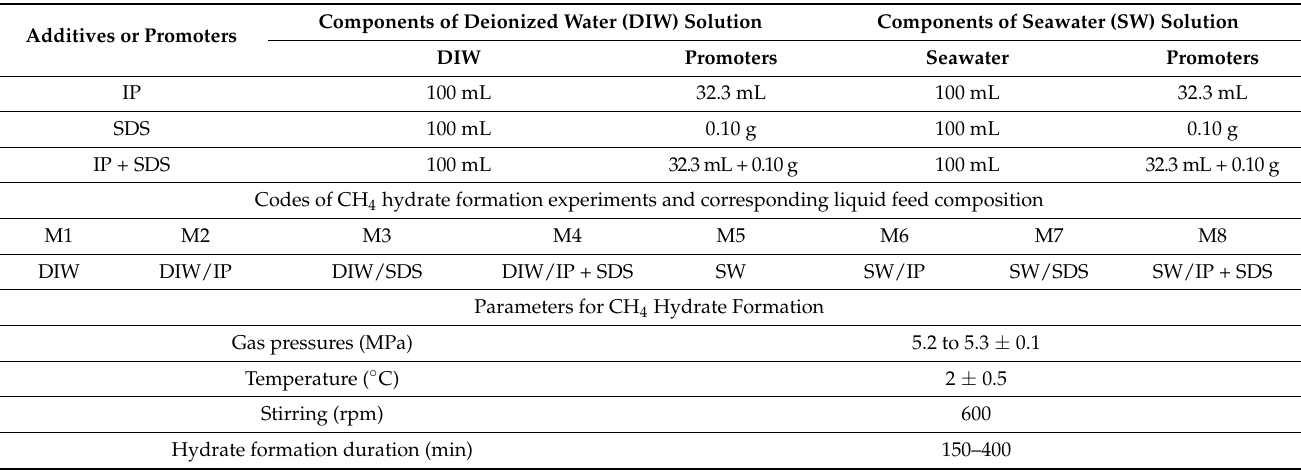
Table 1. Parameters of the solutions used in the study.